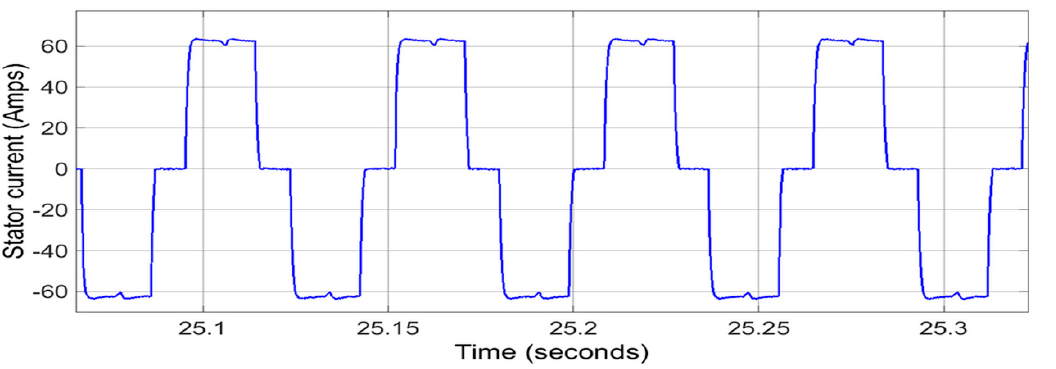
Figure 9. Current waveform over 50 s.